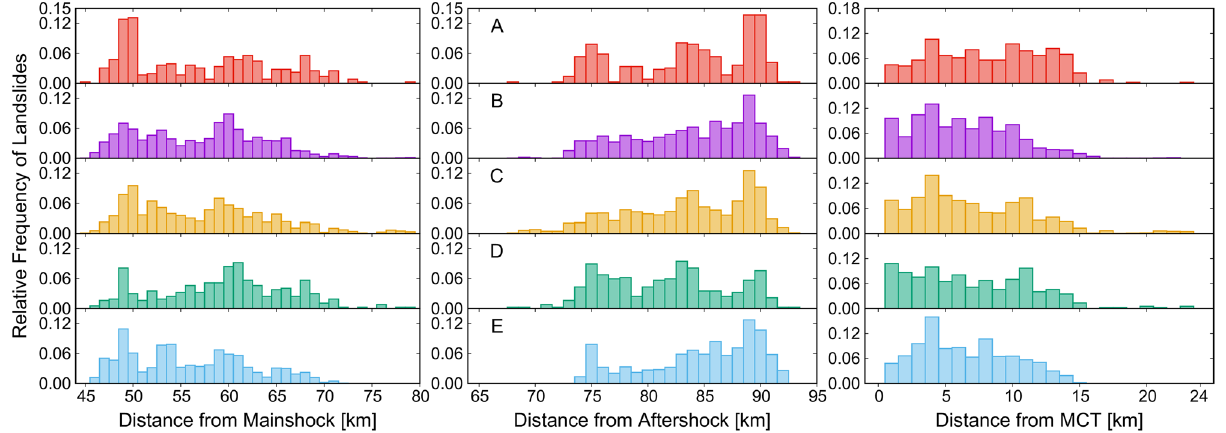
Figure 5. Relative frequency of landslides distance from the mainshock epicenter (left column), from the aftershock epicenter (center column) and the main central thrust (right column), for the overlapping region of all the inventories ( A – E ) considered in this work ( cf. Figure 1).